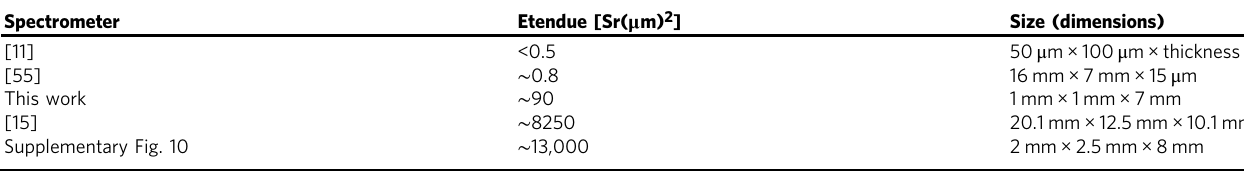
Table 1 Comparison of different spectrometers in terms of throughput (Etendue) and their dimensions